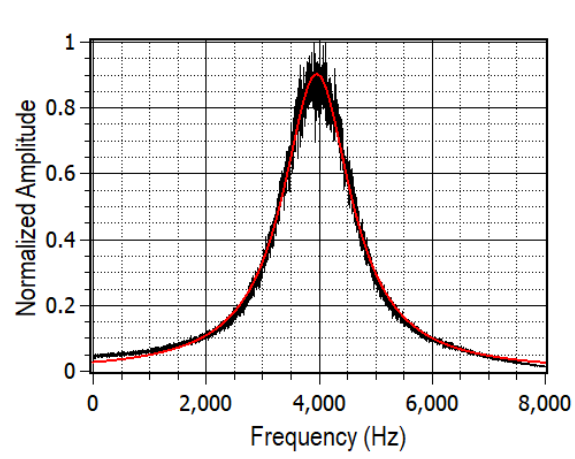
Figure 3. Induced phase noise from 6 km of telecom fiber [9]. The black line shows the beat note measured over 100 s between a reference of the input beam shifted by 80 MHz and the beam at the output of 6 km of telecom fiber. The signal is demodulated in order to center it at 4 kHz. In red, the Lorentzian fit of the beat note is shown, it has a FWHM = 1.48 kHz, R 2 =